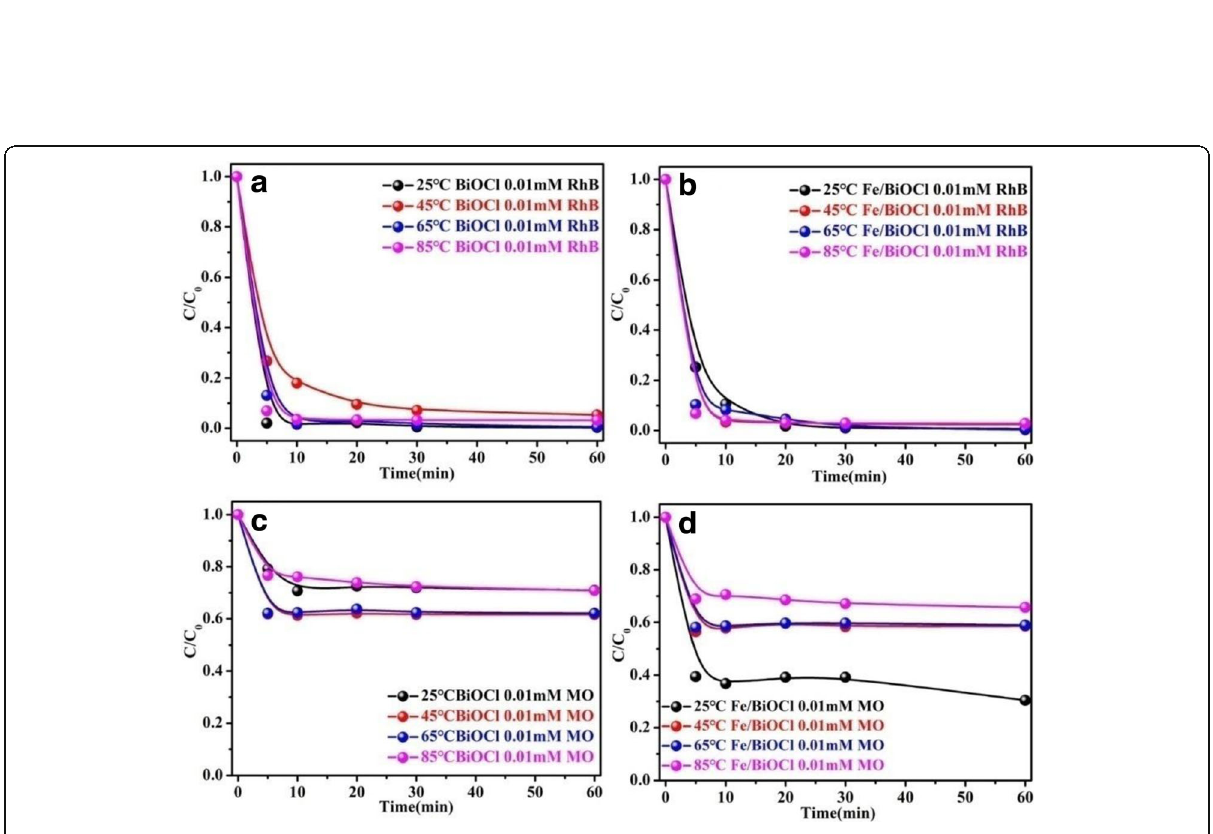
Fig. 8 Effect of temperature on adsorption capacities of BiOCl and Fe/BiOCl toward RhB ( a , b ) and MO ( c , d ) (pH=7, initial concentration=0.01